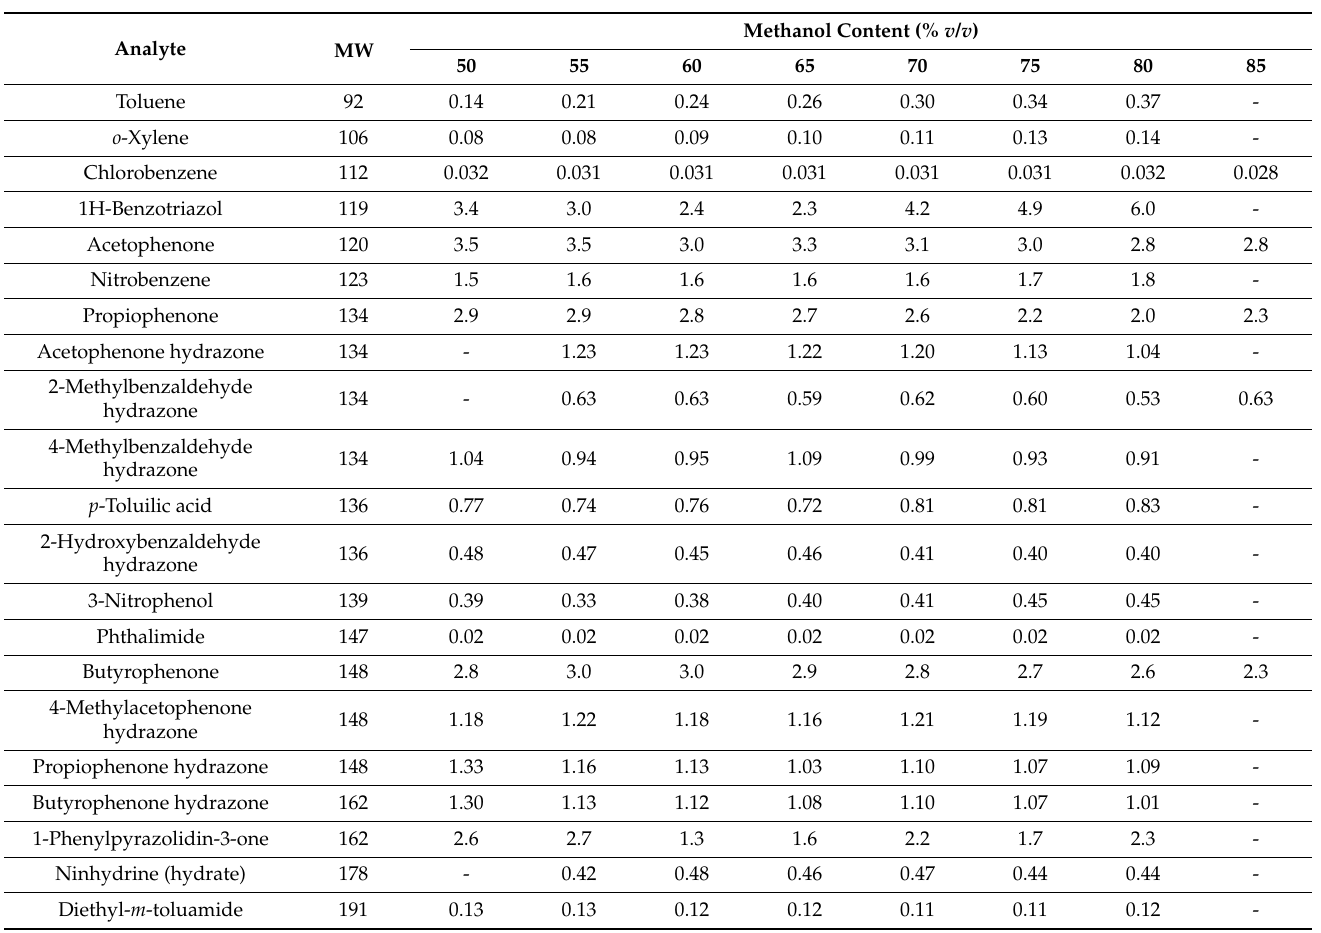
Table 4. Relative optical densities A (254)/ A (220) of some organic compounds, depending on the methanol content in the